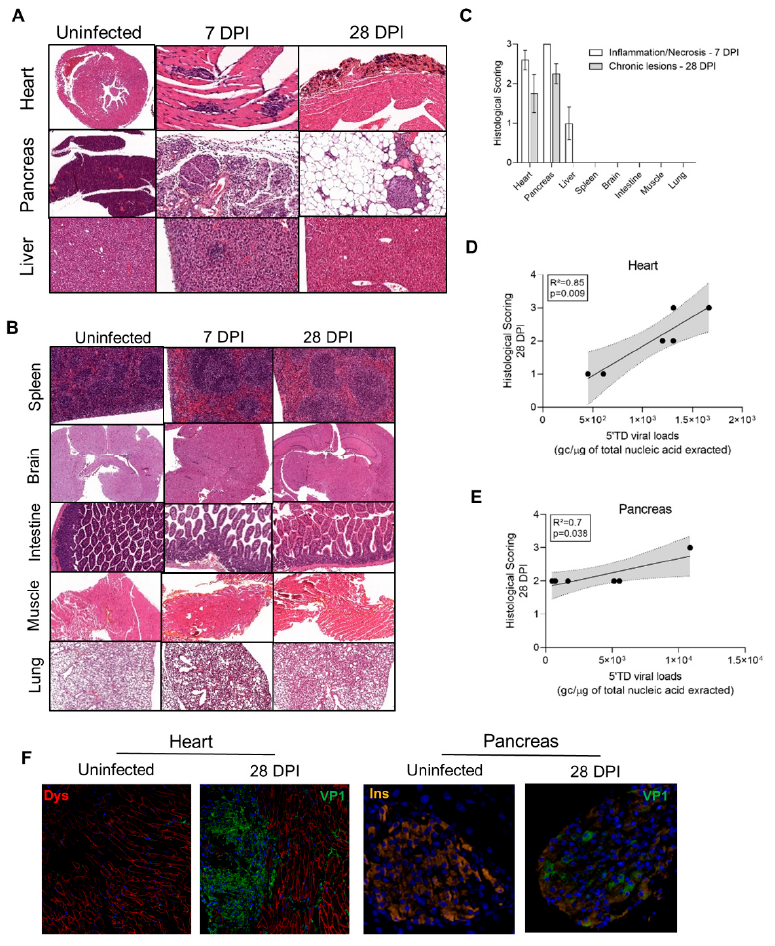
Figure 4. Histological lesions and cell dysfunctions in organs of CVB3/28-infected DBA/2J mice. ( A ) In the infected group, cardiac lesions were found from 7 DPI to 28 DPI. Infected mice exhibited multiple inflammatory foci at 7 DPI. At 14 and 28 DPI, calcified fibrosis was found. At 7 DPI, diffuse pancreatic inflammatory infiltrates with necrosis were found, sparing islets cells. After 14 DPI, an adipose tissue replacement was found, sparing islets cells. Hepatitis was found at 7 DPI,